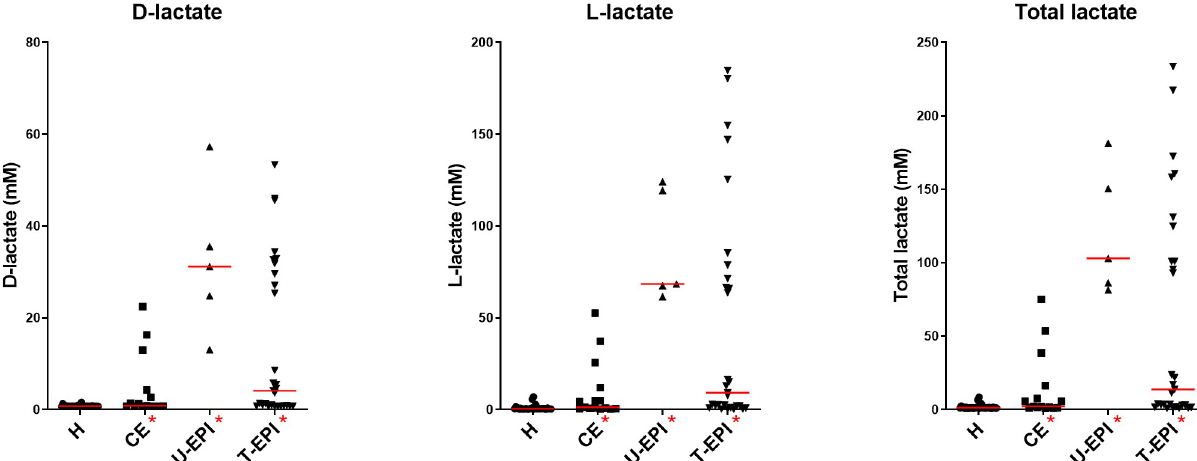
Fig 1. Lactate concentrations (mM) in the feces of healthy and diseased dogs. The groups on the x-axis are defined as follows: H = healthy dogs, AHD = dogs with acute hemorrhagic diarrhea, CE = dogs with chronic enteropathy, U-EPI = dogs with exocrine pancreatic insufficiency not receiving enzyme replacement therapy, T-EPI = dogs with exocrine pancreatic insufficiency receiving enzyme replacement therapy. Groups marked with a red asterisk are significantly different from the healthy control group.